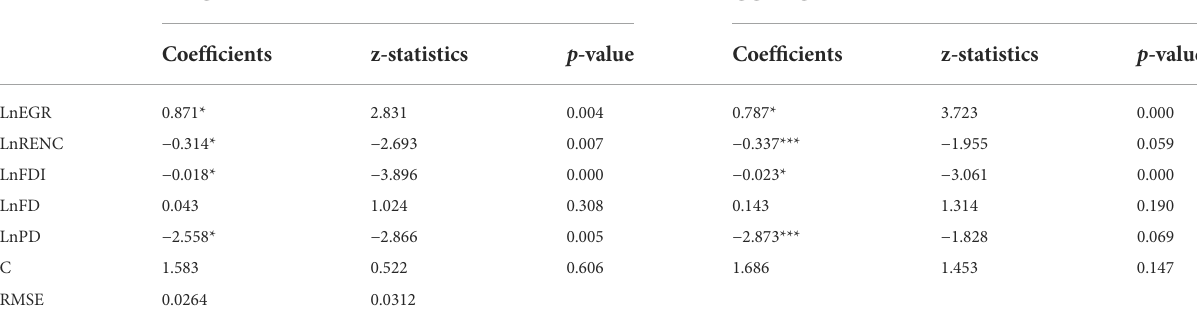
TABLE 5 AMG and CCEMG results.